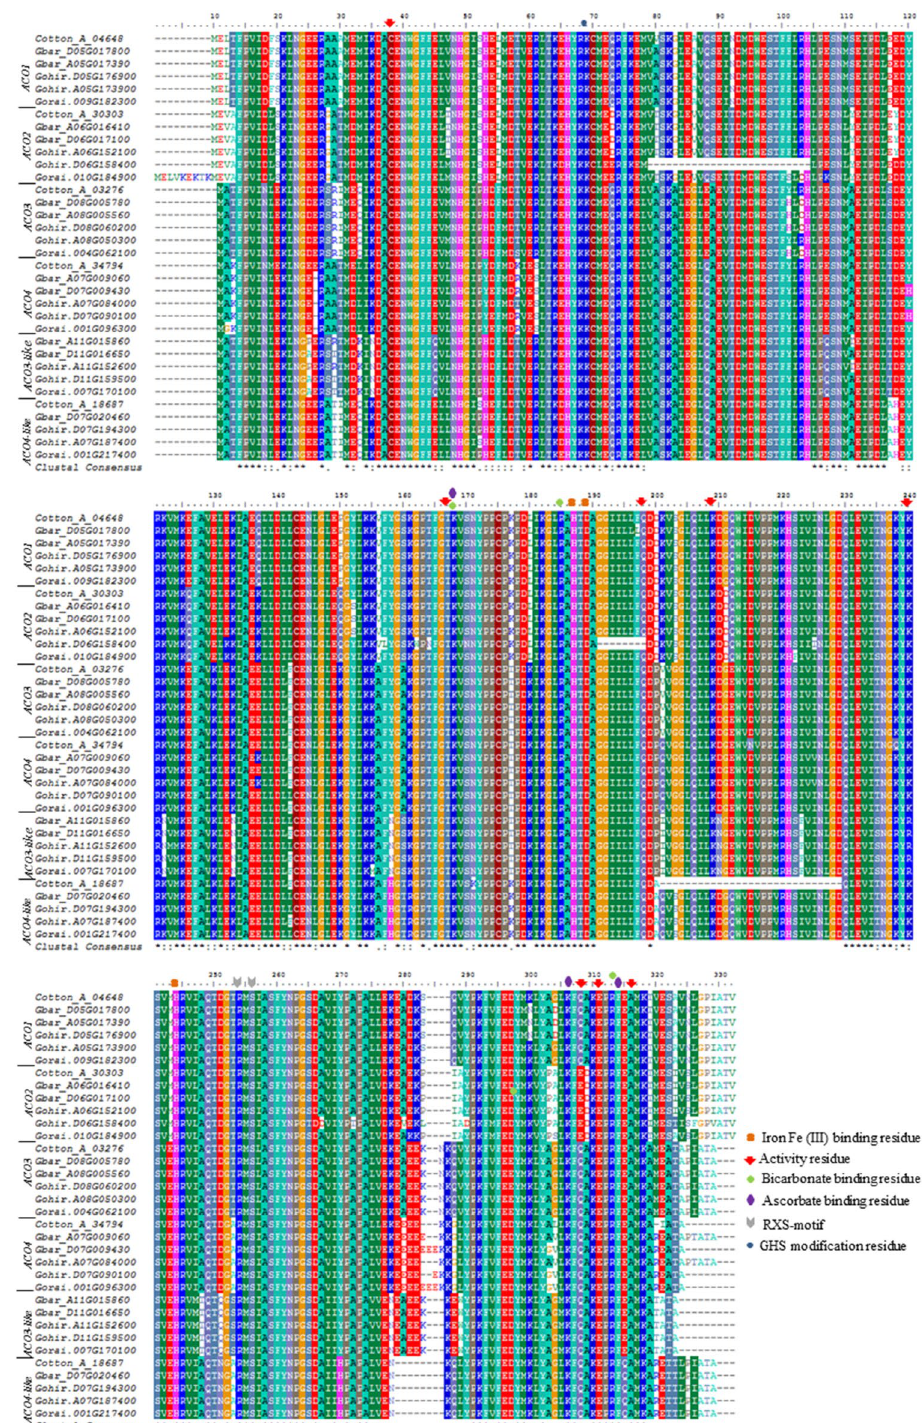
Figure 3. Residue analysis of ACO isoforms in Gossypium spp. ( G. arboreum , G. raimondii , G. hirsutum and G. barbadense ). Marked legends represent the important